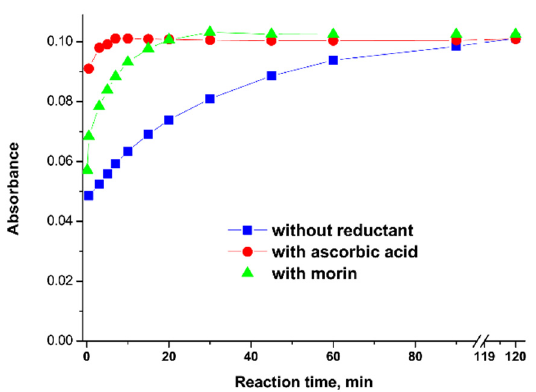
Figure 3. The changes in absorbance at 542 nm ( λ max for complex) over time for the reaction of Cu(II) and TCPP in the presence of ascorbic acid and morin. [Cu 2+ ] = [TCCP] = [ligands] = 10 − 5 M. Reprinted with permission from [59]. 2016. Copyright Elsevier.